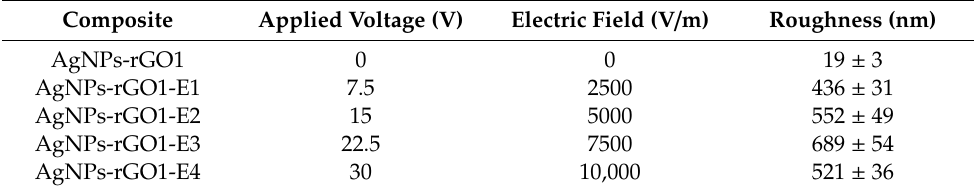
Table 1. Roughness of the fabricated AgNPs-rGO composites using di ff erent DC electric fields. Composite Applied Voltage (V) Electric Field (V / m) Roughness (nm) AgNPs-rGO1 0 0 19 ± 3 AgNPs-rGO1-E1 7.5 2500 436 ± 31 AgNPs-rGO1-E2 15 5000 552 ± 49 AgNPs-rGO1-E3